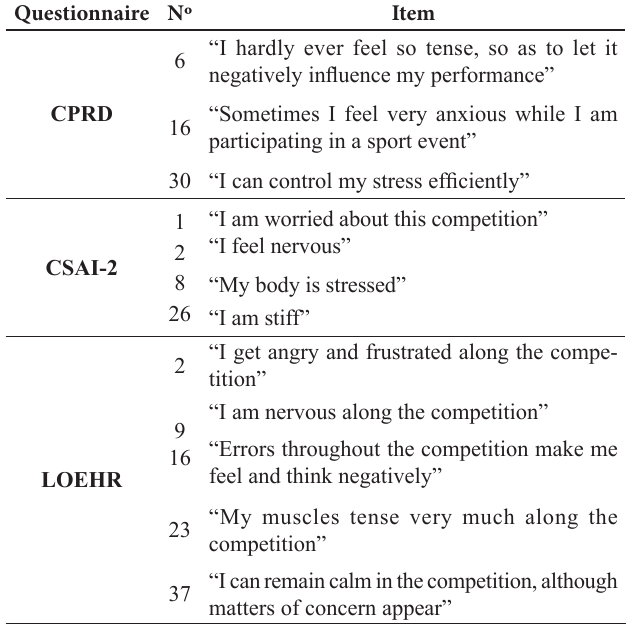
Table 6 lists the data resulting from the correlation of